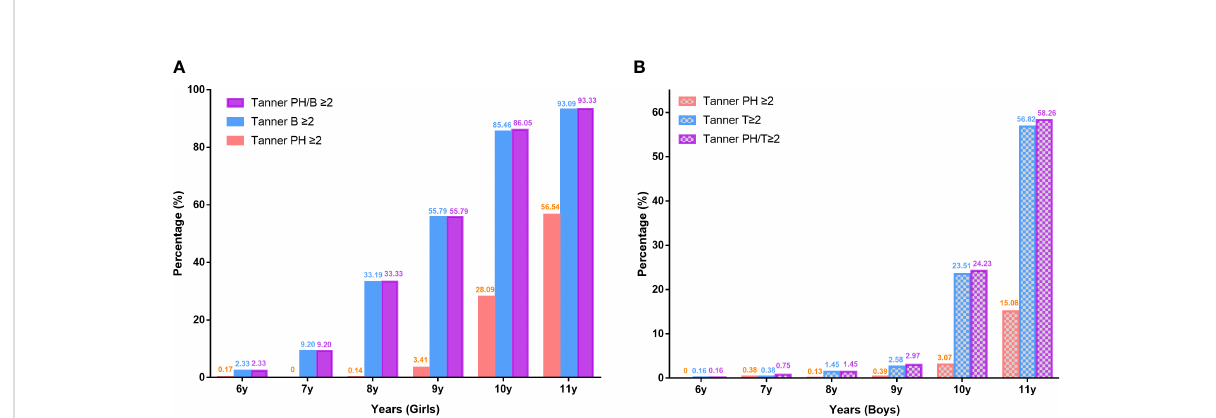
FIGURE 1 Prevalence of testicle, breast, and pubic hair development according to pubertal stages at different ages in girls (A) and boys (B) . Ph, pubic hair; T, testicle; B, breast.